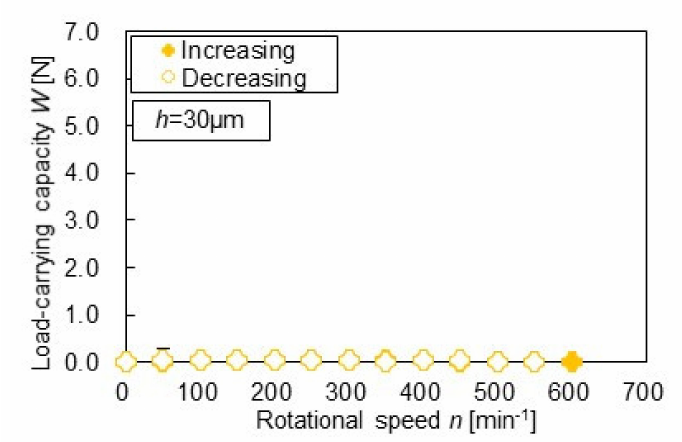
Figure 8. The load-carrying capacity for plane specimen.